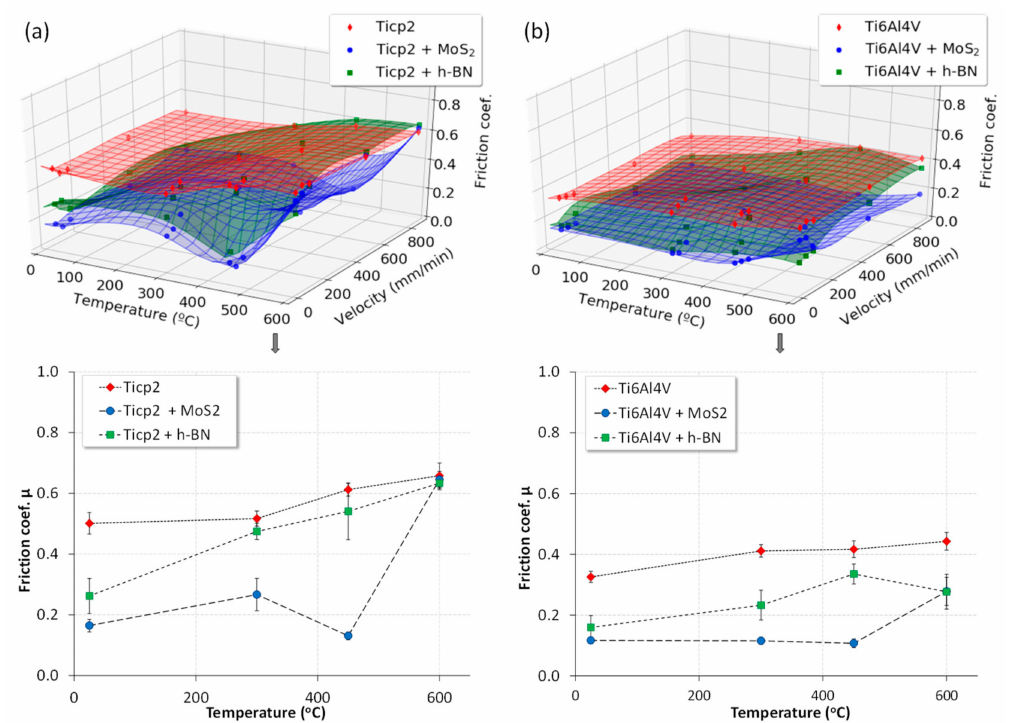
Figure 4. Friction coefficients obtained: ( a ) Ticp2; ( b )